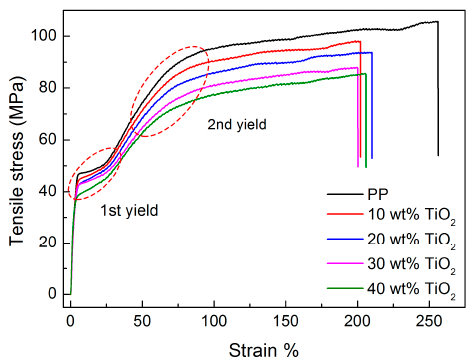
Figure 4. Stress–strain curves of the annealed PP and PP/TiO 2 composite films with different TiO 2 concentrations.